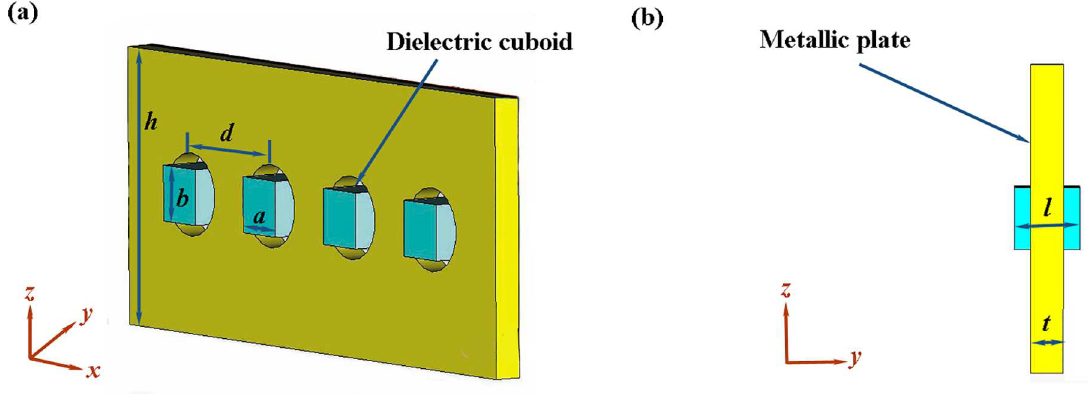
Fig 1. Schematic diagram of the microwave bandpass filter structure based on periodically metallic apertures filled with dielectric particles. (A) perspectiveview and (B) cross-section ( yz -plane)